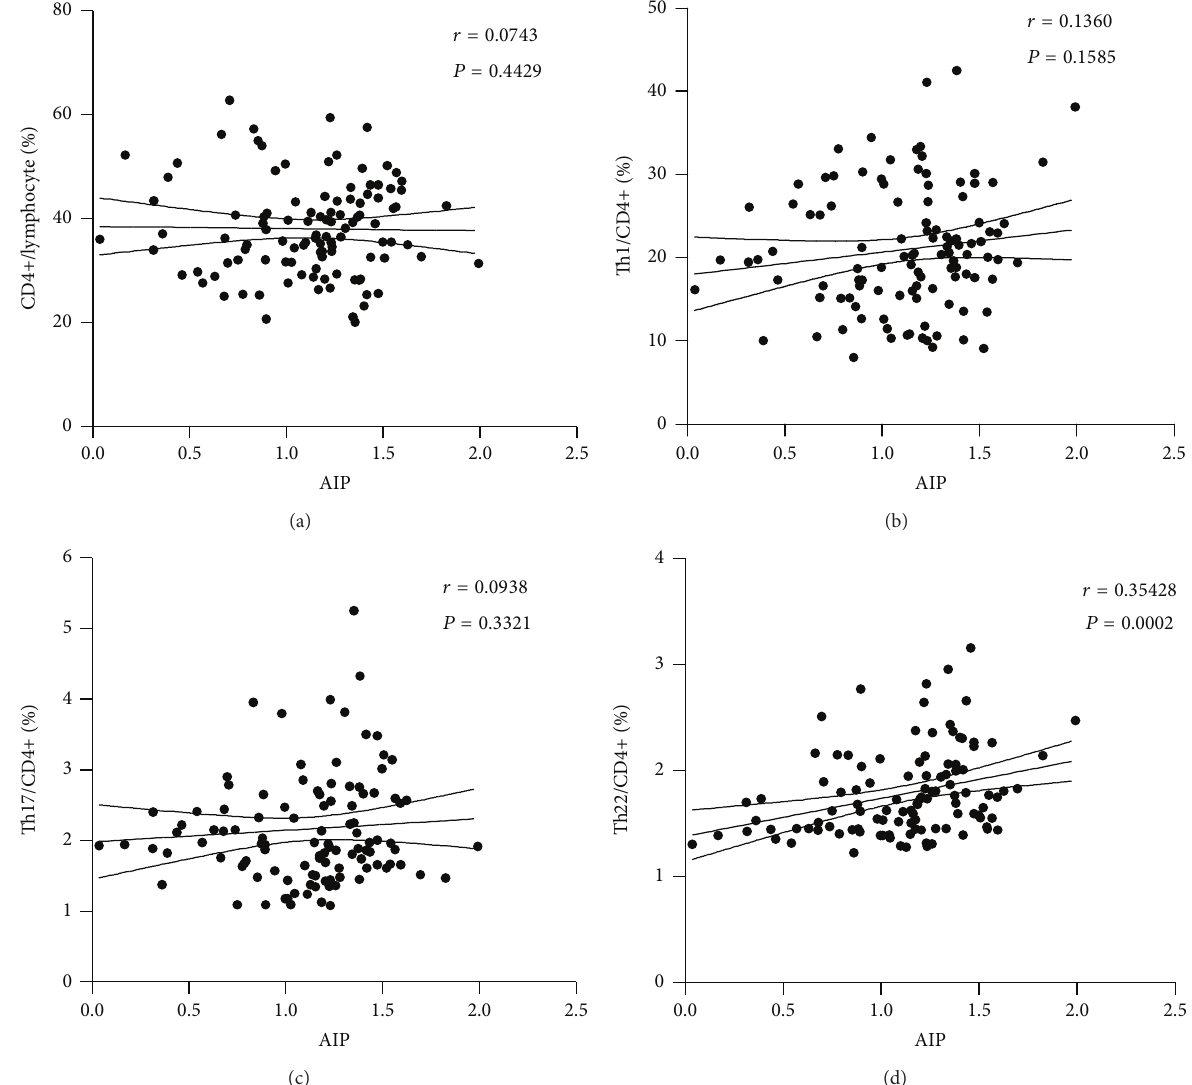
Figure 3: Correlation analysis of peripheral frequencies of Th22, Th1, and Th17 cells with AIP correlation analysis of proinflammatory Th subset frequency with atherogenic index of plasma (AIP) in T2D patients. The positive correlation of Th22 frequency with AIP was proved to be statistically significant (d). However, correlation of AIP with Th1 or Th17 frequency failed to show statistical significance (b, c). Numbers in each figure show Spearman 𝑟 and 𝑃 value,